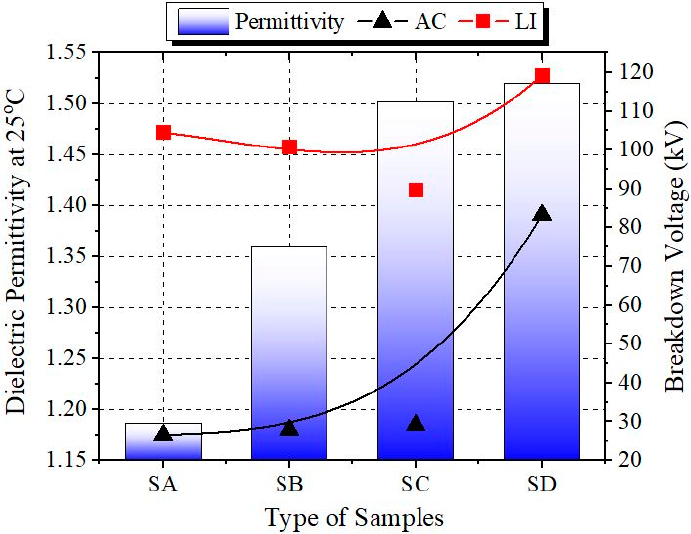
Figure 13. Influence permittivity of oil samples towards breakdown voltage (BDV) and lightning impulse (LI) measurements at ambient temperature.